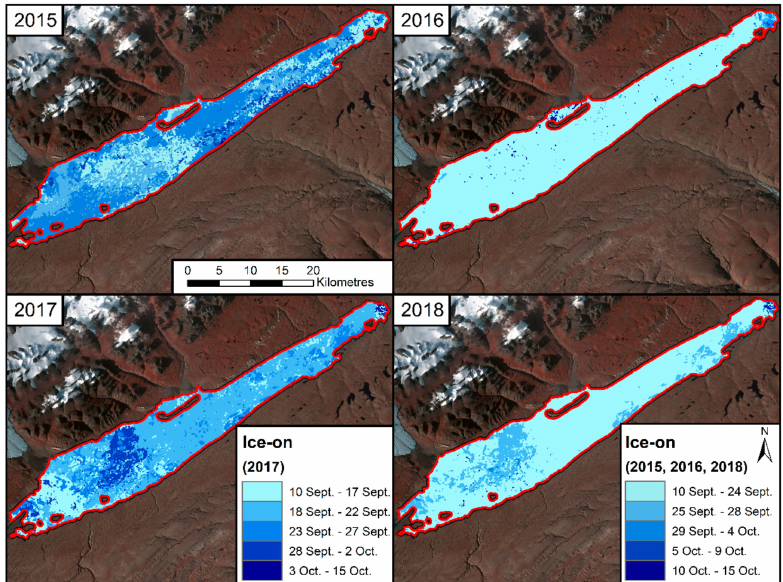
Figure 10. Ice-on dates for Lake Hazen, determined on a pixel by pixel basis using the first di ff erence method, from 2015–2018. Landsat-8 Level-1 image courtesy of the U.S. Geological Survey (Digital Object Identifier (DOI) number: / 10.5066 /